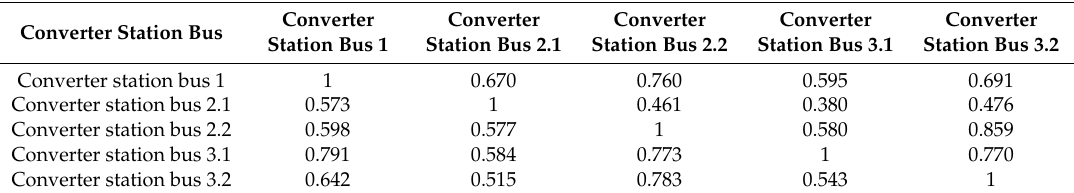
Table A4. The MIIF of converter station buses with Area 3 to be isolated.